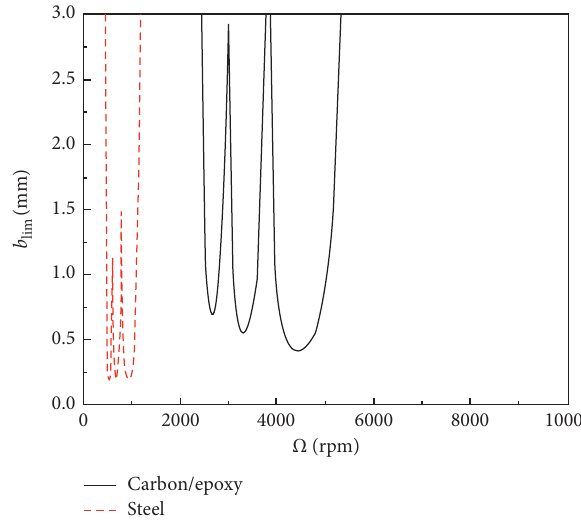
Figure 8: The limit cutting depth versus rotating speed for carbon/ epoxy and steel cutter bars.